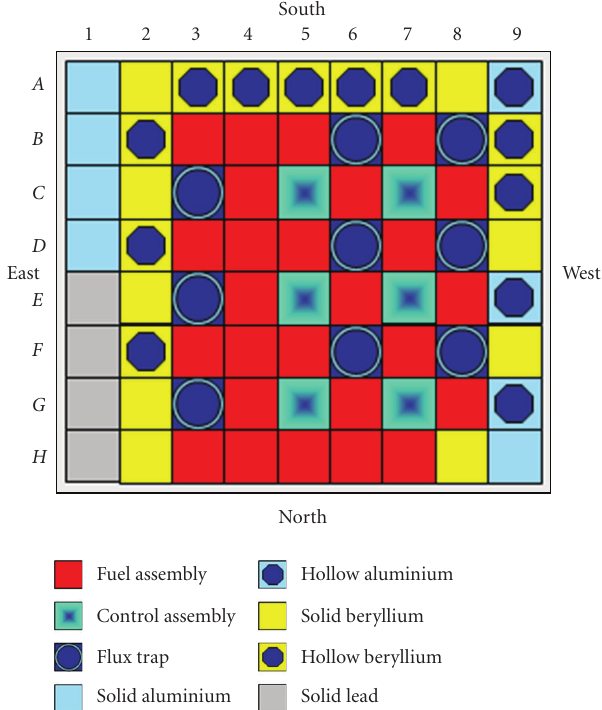
Figure 1: SAFARI reactor core